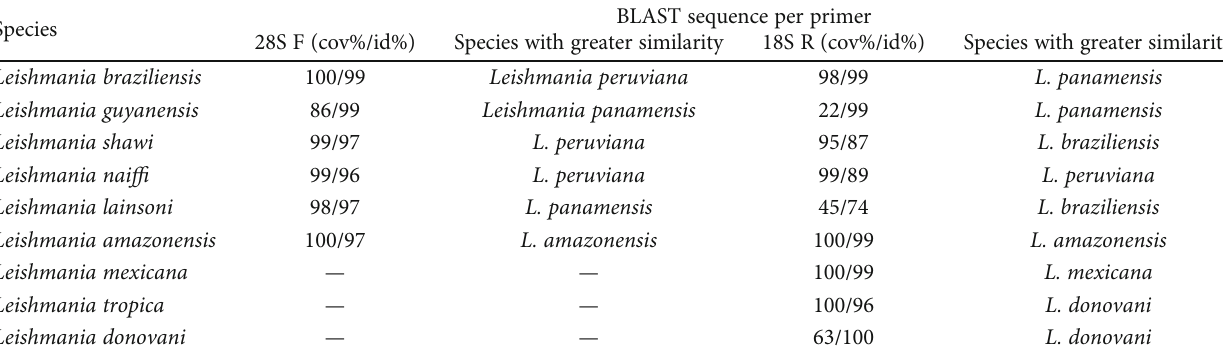
Table 5: BLAST n analysis of Leishmania species sequenced from 28S F and 18S R primers. Species